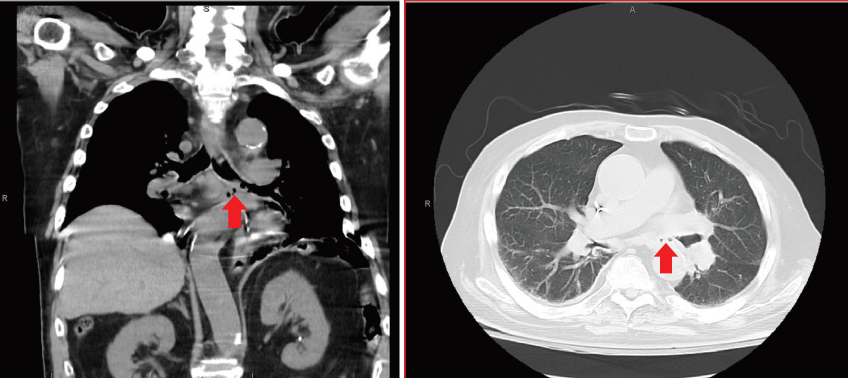
Figure 2: CT image without contrast of the patient’s chest. Arrows indicating extraluminal air tracking from the left mainstem bronchus towards the